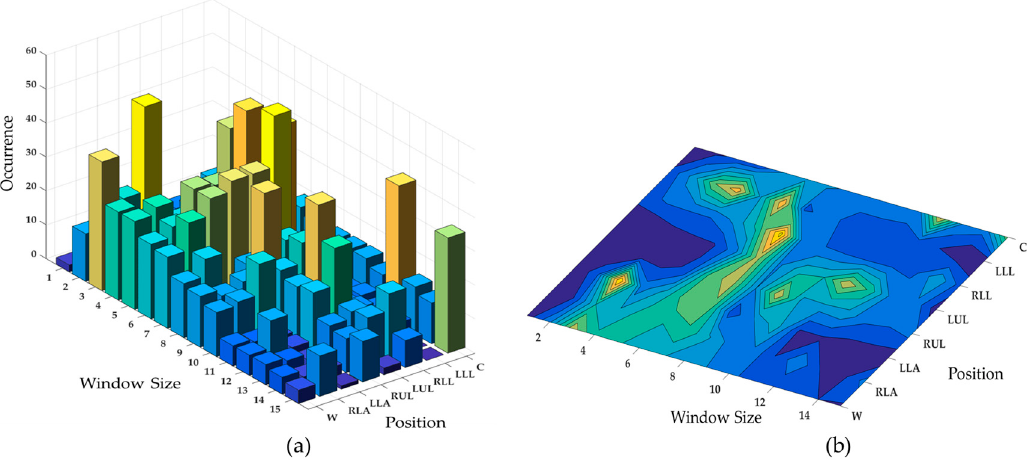
Figure 7. Effect of window size to gain meaningful information for the activity classification in ( a ) 3D and ( b ) 2D representations.